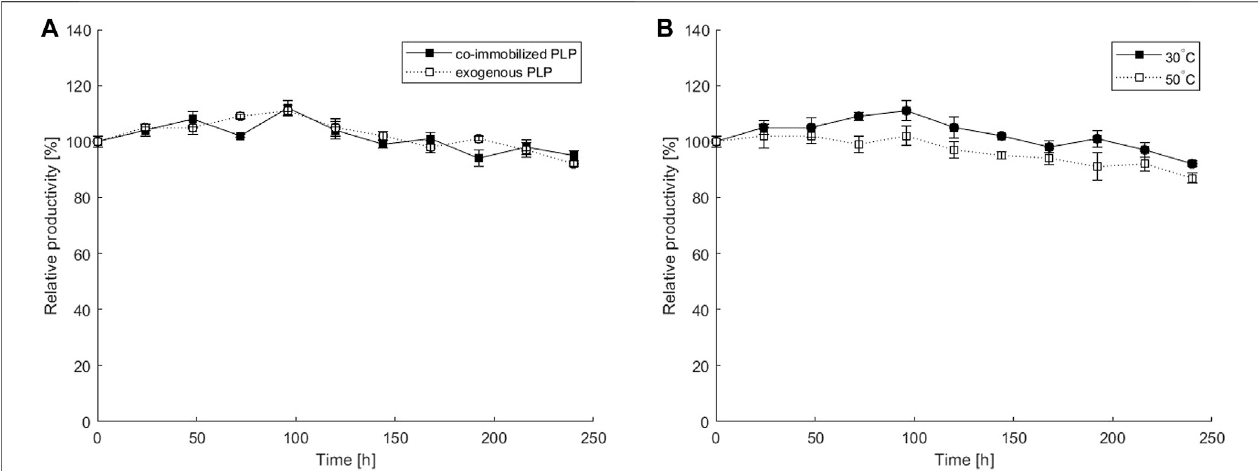
FIGURE 6 | Operational stability of a microbioreactor over a 10-day period: (A) estimated at 30 ° C with 0.1 mM PLP co-immobilized in a hydrogel or exogenously added ina fl uid stream; (B) estimated for0.1 mM PLPco-immobilizedin ahydrogelat 30 ° C or 50 ° C. Allexperiments wereperformedat 2 μ L min − 1 fl owrate and withan equimolar substrate concentration of 40 mM and ATA-v1 concentration of 0.81 mg ml − 1 . The initial STY at 30 and 50 ° C were 15.2 U g − 1 and 19.4 U g − 1 , respectively. Error bars indicate standard deviations of triplicates.